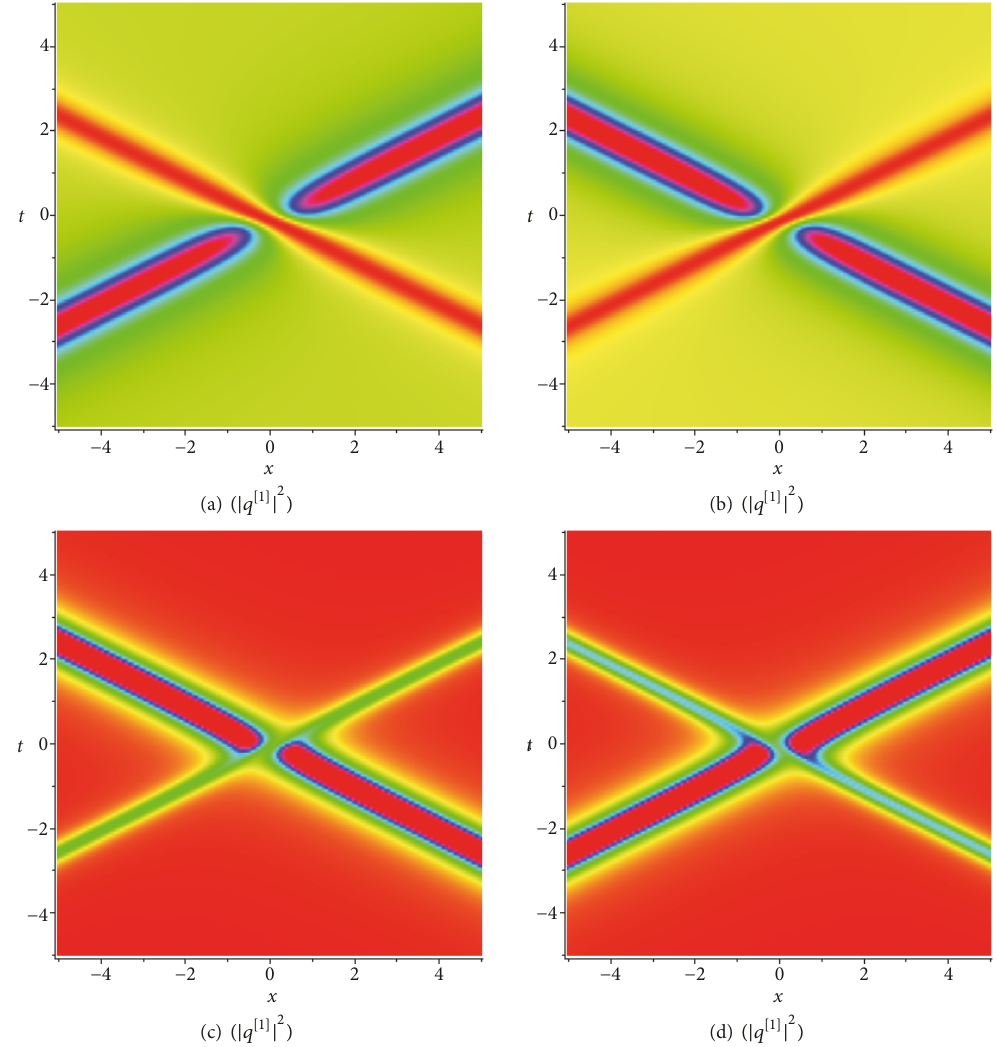
Figure 2: Density plots of |𝑞 [1] | 2 on (𝑥,𝑡) -plane associated with Figure 1. (a) The dark-bright structure: (𝐽 1 , 𝐽 2 ) = (2,3) . (b) The bright-dark structure: (𝐽 1 , 𝐽 2 ) = (0.2,0.2) . (c) The bright-bright 1 structure: (𝐽 1 ,𝐽 2 ) = (0.2, −0.1) . (d) The bright-bright 2 structure: (𝐽 1 , 𝐽 2 ) = (3, −1) .